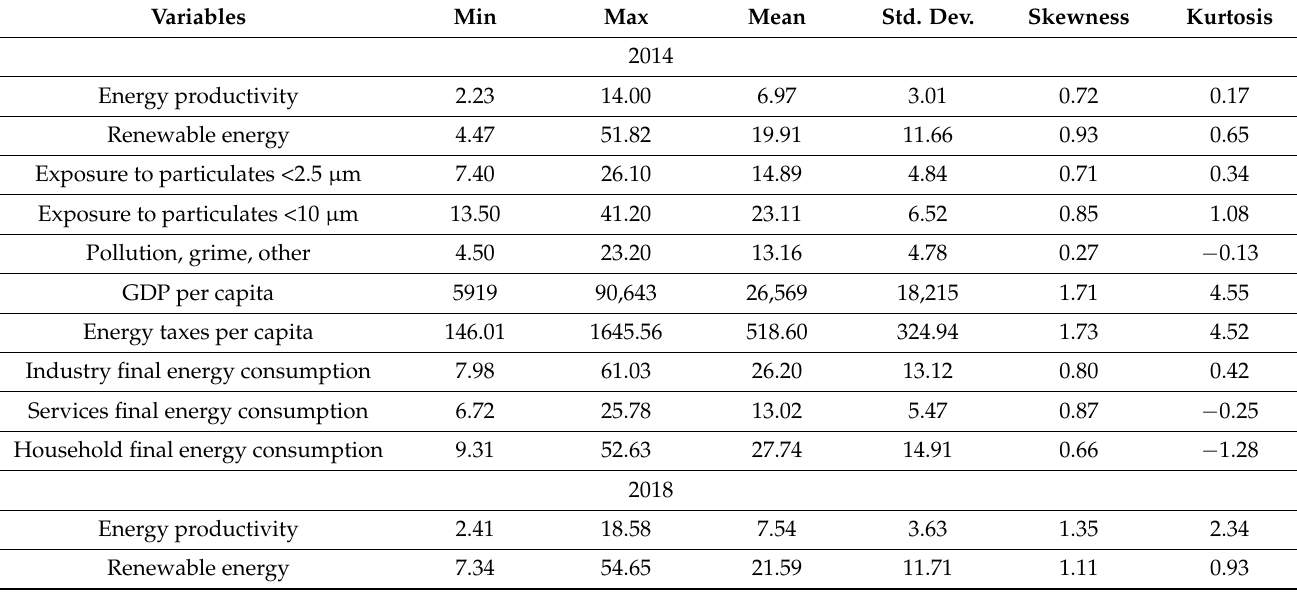
Table 1. Descriptive statistics of the final variables selected for